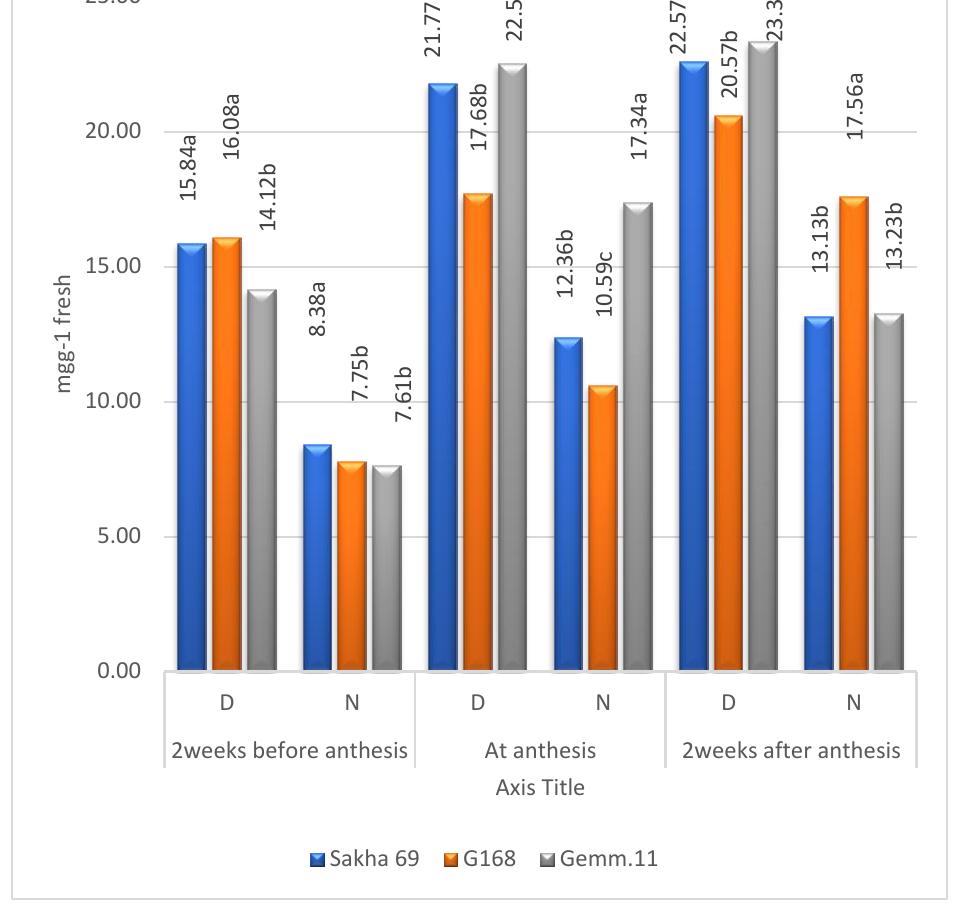
Figure 5. Combined means of soluble proteins for cultivars under drought stress (D) and irrigation (N); means followed by the same letter in each environment are not significant at the 0.05 level of probability according to LSD test.